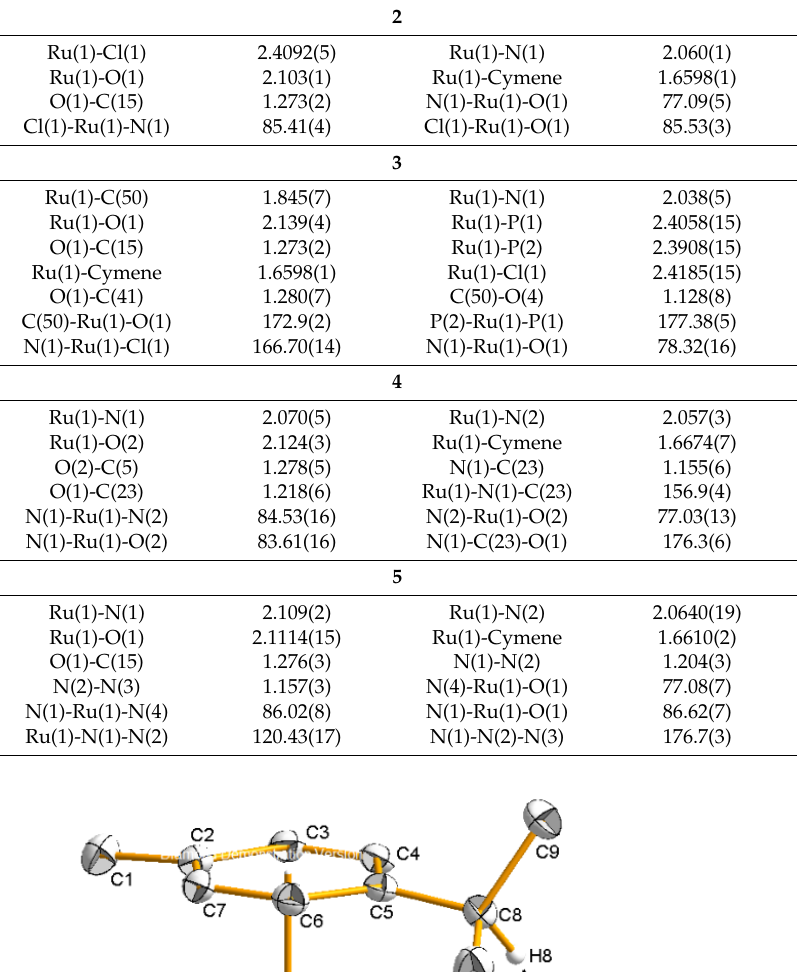
Table 2. Selected bond lengths (Å) and angles (°) for Compounds 2 – 5 .